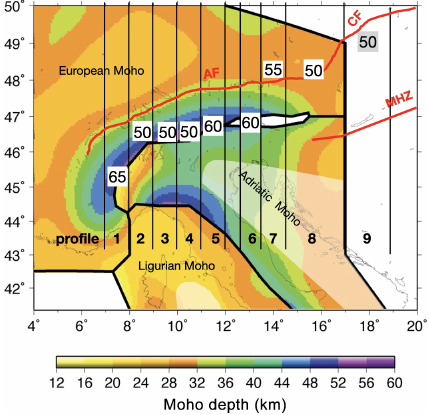
Figure 15. Moho map of Spada et al. (2013) indicating the pro- visional maximum recorded depths of the Moho along the Alpine chain west of 13.5 ◦ E, below the southern part of the Bohemian Massif and below the northernmost Western Carpathians, marked in kilometres. These depths are still provisional because we still need to provide do a comparison of the Moho and SV waveforms for more accurate depth determinations in the future. Numbers are taken from profiles in Figs. 3a to 11a. AF, CF and MHZ mark the Alpine Front, Carpathian Front and Mid-Hungarian Fault Zone, re- spectively.